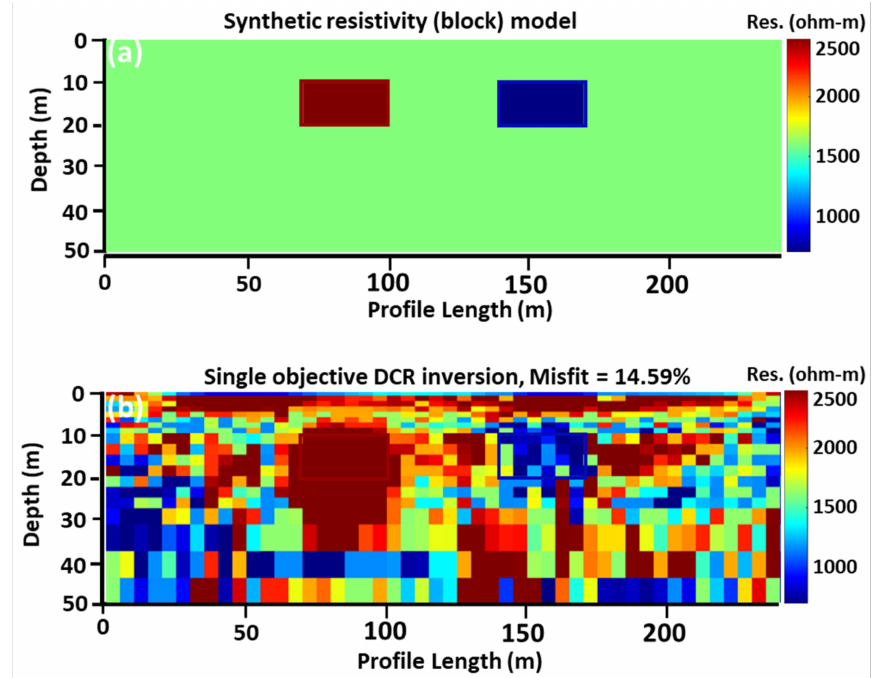
Figure 13. Positive and negative anomaly model inversion using the single objective global optimiza- tion method; ( a ) synthetic dc-resistivity model and ( b ) single object inverted resistivity model. The dark red/blue lines are used to mark the anomaly boundary.